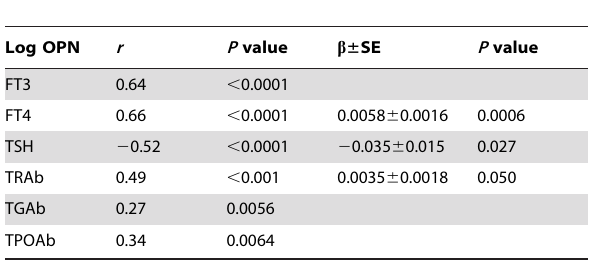
Table 3. Pearson’s correlation and multiple stepwise linear regression analysis of OPN associated with classic GD diagnostic